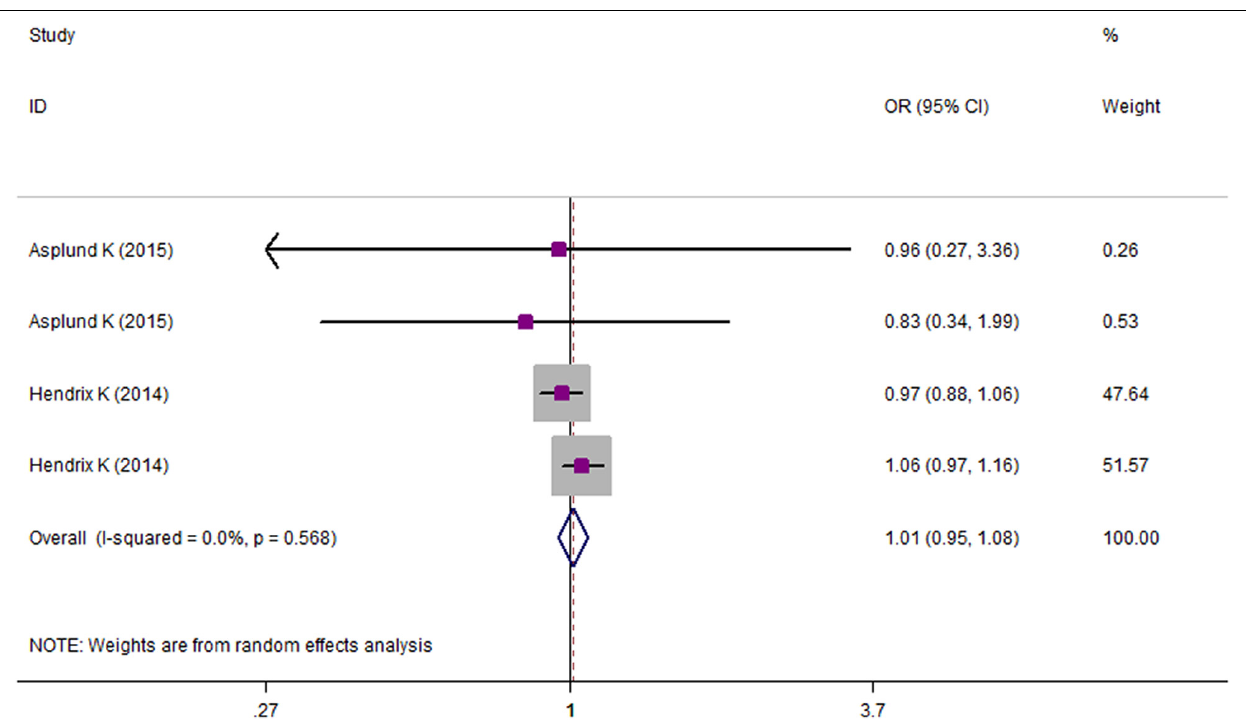
FIGURE 4 | The association between obesity and pooled odds ratio (OR) of screen addiction. I 2 represents the degree of